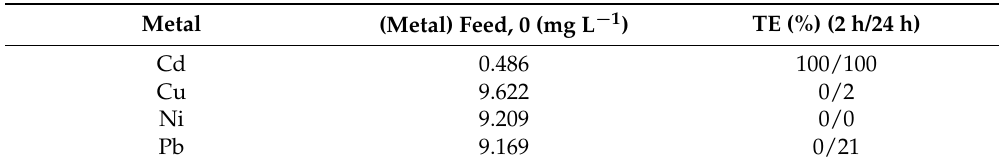
Table 2. Selectivity studies of the SLM system. Feed phase: metals in 2 M HCl; SLM: 0.5 M Aliquat 336 in decaline.